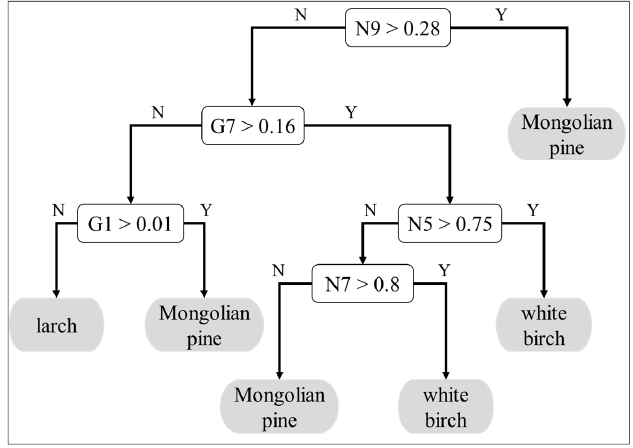
Figure 4. A 5-node CART decision tree for the three tree species. The thresholds are summarized from the CART outputs of the training samples.